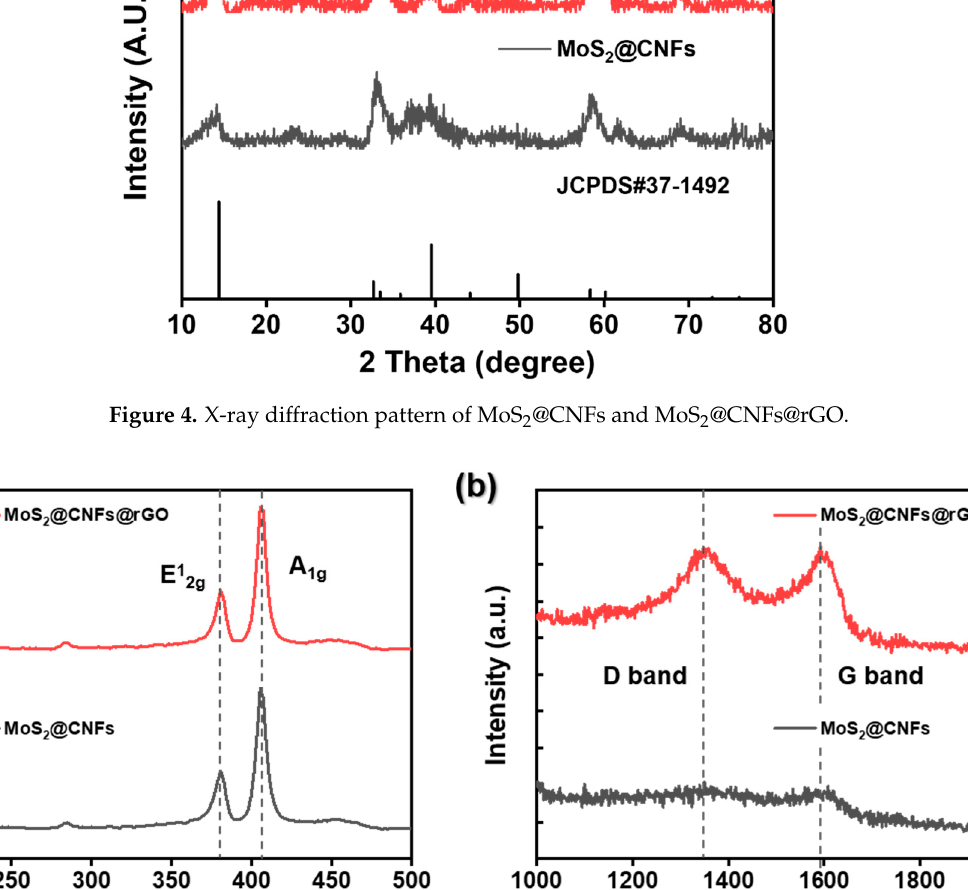
Figure 5. Results of Raman analyses of MoS 2 @CNFs and MoS 2 @CNFs@rGO with different ranges: ( a ) 200~500 cm − 1 , ( b ) 1000~2000 cm − 1.